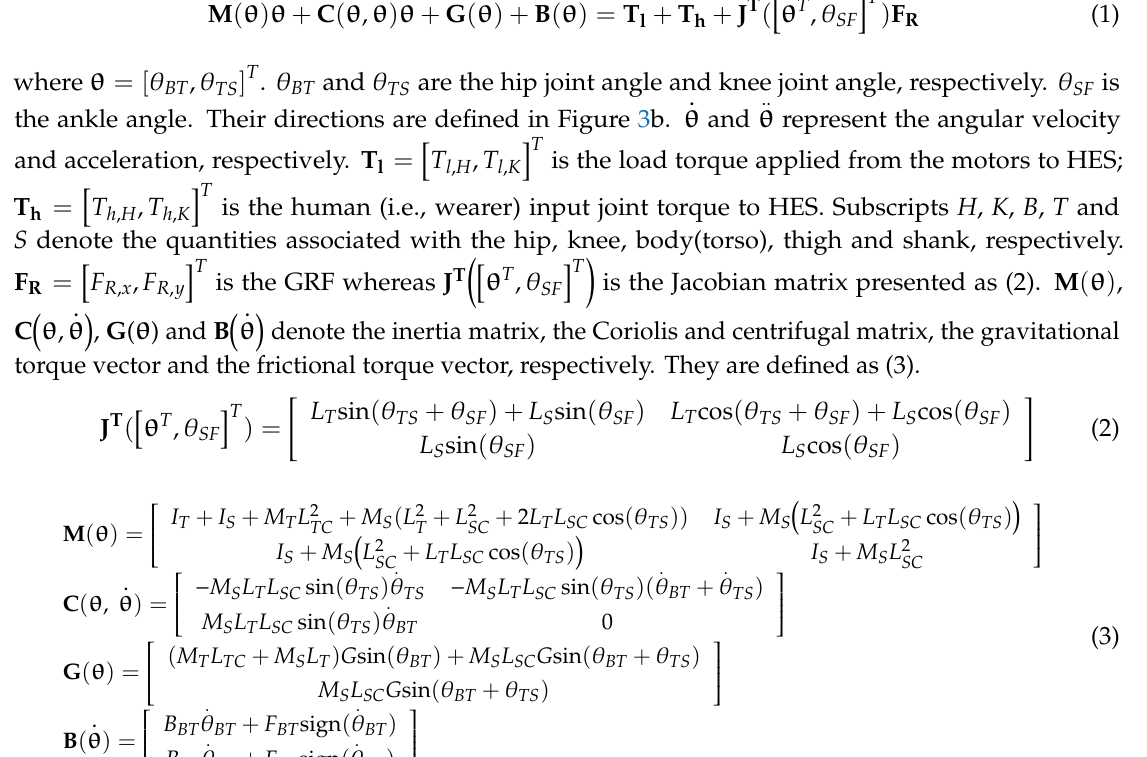
Figure 3. ( a ) Single-leg dynamic model of the exoskeleton; ( b ) the definitions of the joint angle directions and the joint angle limitations. The black, blue, green and brown solid line are the foot, shank, thigh and torso (i.e., body), respectively. The dotted lines represent the limb extension to the connected limb. The single-leg dynamic model equation is shown as